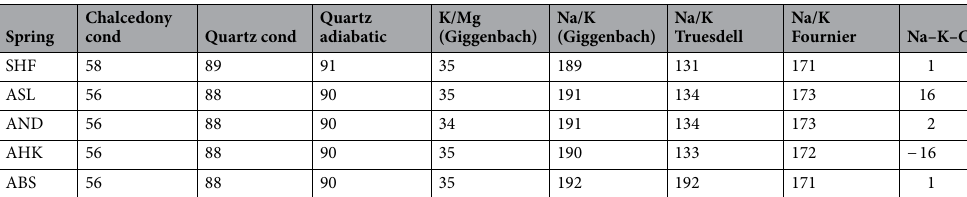
Table 3. Results of different geothermometric methods in studied locations [temperatures are reported in degrees celsius (°C)].